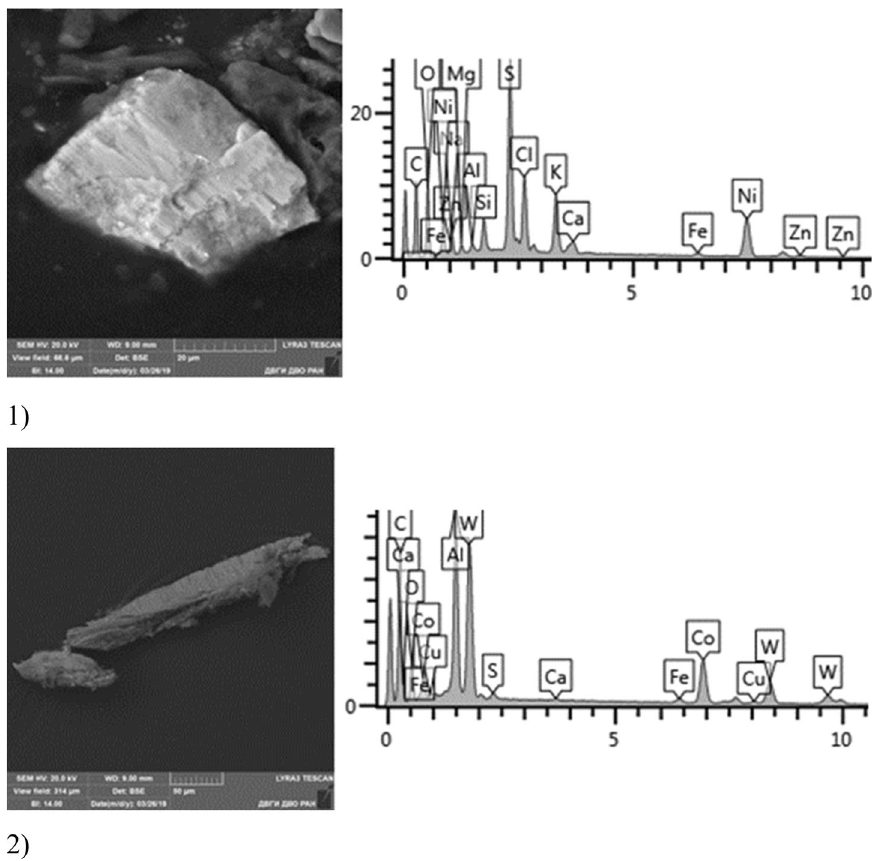
Figure 15. Nickel plating. Particles morphology. Scanning electronic microscopy. 1) Measuring interval 20 µm, 2) Measuring interval 50 µm.